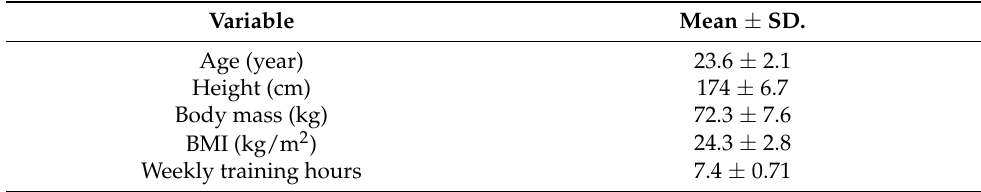
Table 1. Demographic details of